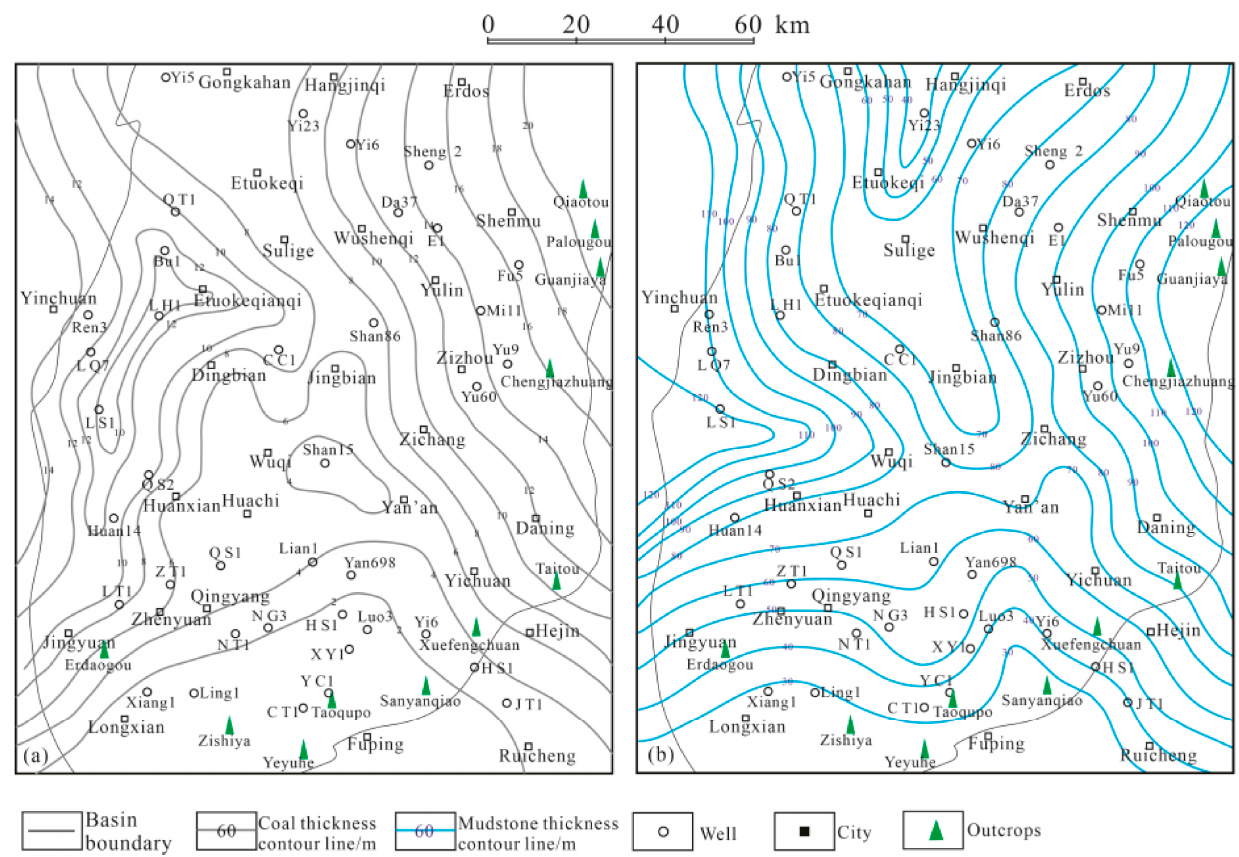
Figure 4. Distribution of the Upper Paleozoic coal measure source rocks in the Ordos Basin.